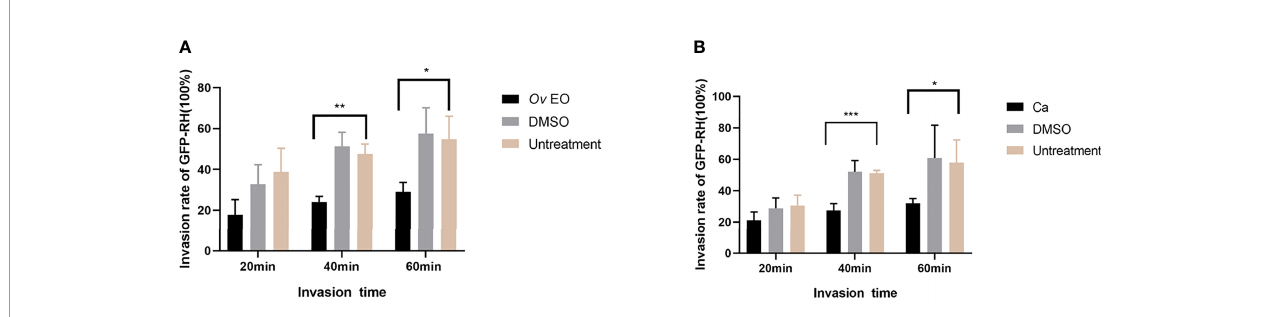
FIGURE 6 | Effect of Ov EO on the invasion of T. gondii. Statistics of T. gondii invasion rate using two immuno fl uorescent dyes after treated with Ov EO (A) and Ca (B) for 20, 40, 60 min, respectively. * P < 0.05, ** P < 0.01, *** P < 0.001 compared with untreated